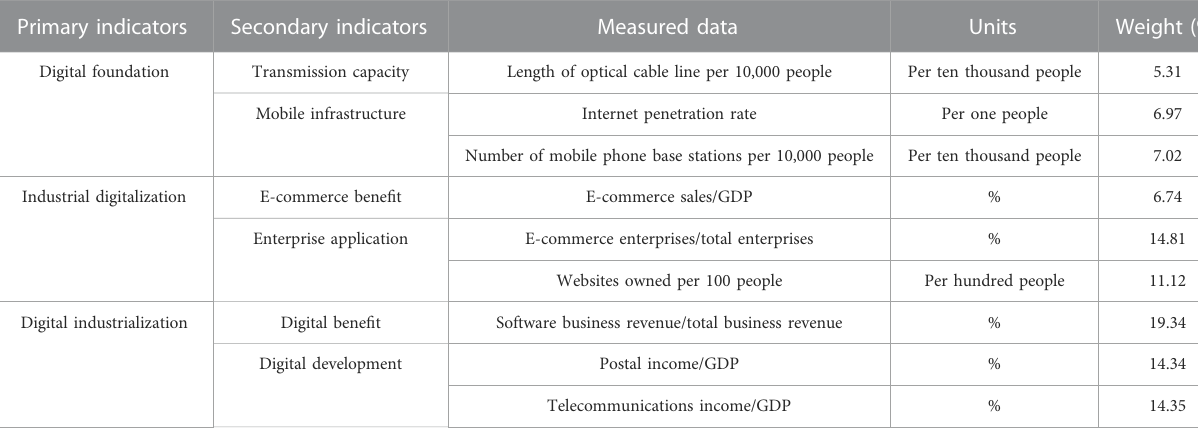
TABLE 1 Comprehensive evaluation index system of digital economy degree.